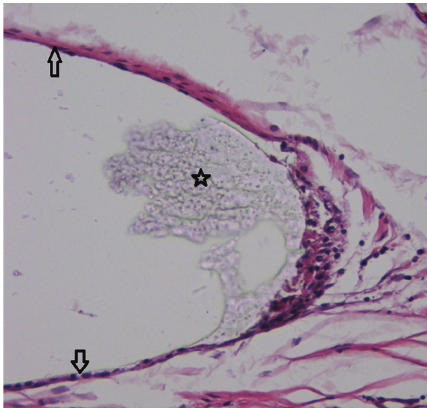
Figure 5: Weak fibrous capsule around the biomaterials marked by